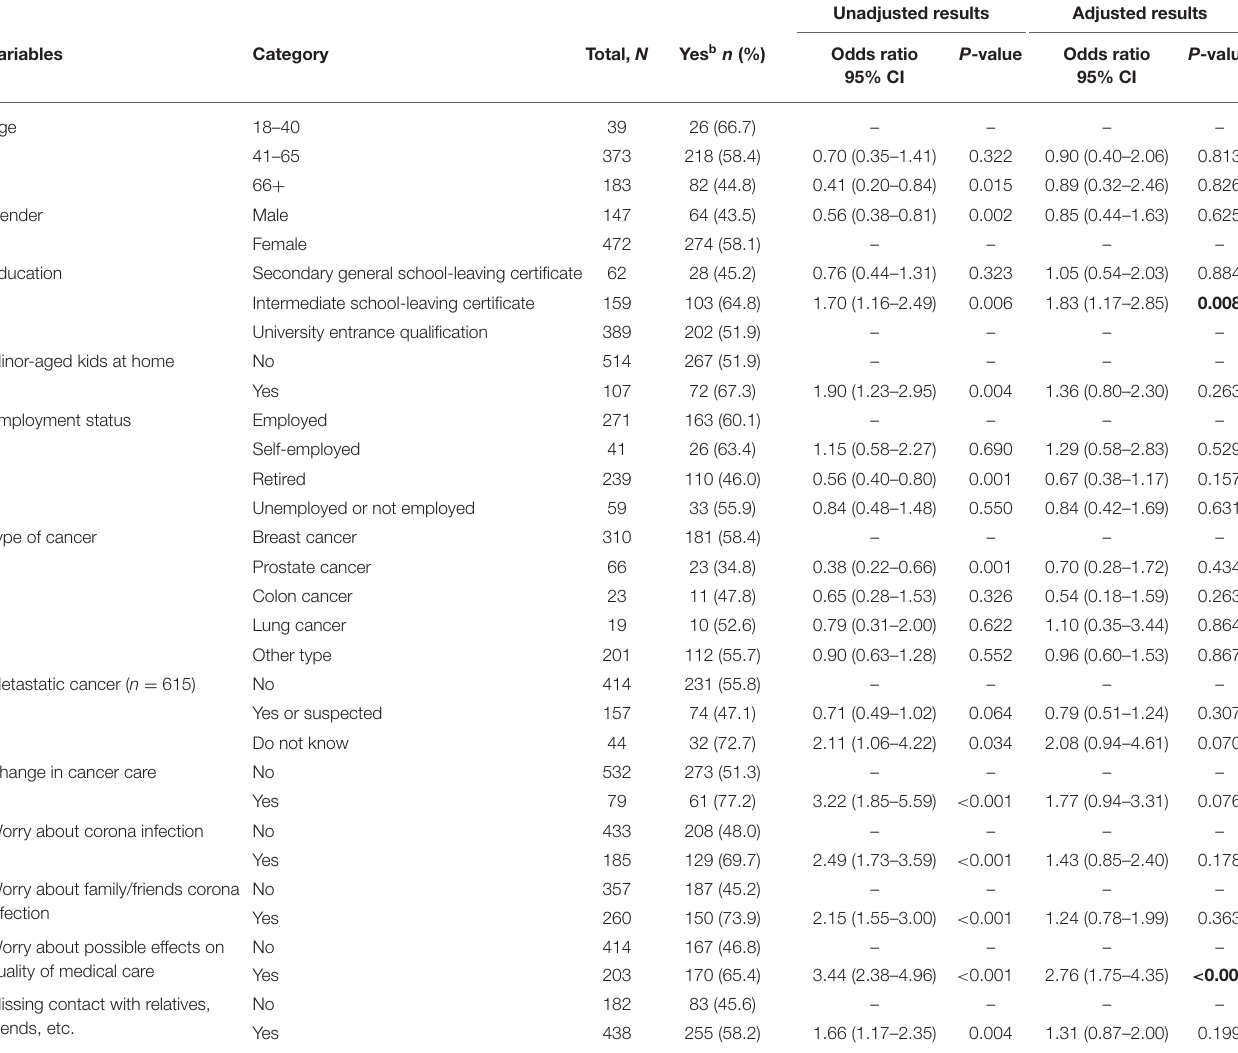
TABLE 7 | Logistic regression of associated factors for symptoms of anxiety a